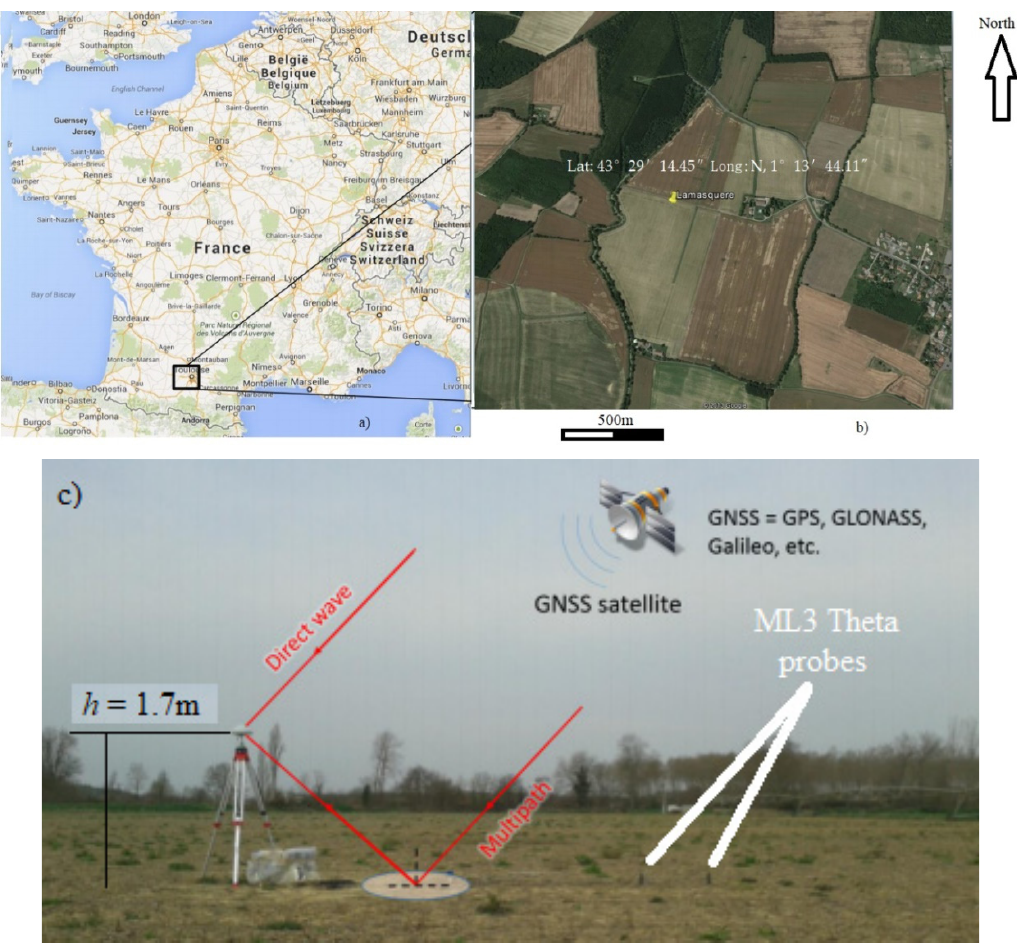
Figure 2. Lamasquère Experiment location: ( a ) map of France with a black box locating the region surrounding Lamasquère; ( b ) zoom on the Lamaquère plots where the measurements were taken (yellow dot); ( c ) zoom on the installed instrumentation with 2 ML3 Theta probes and Leica GR25 receiver and AR10 antenna.